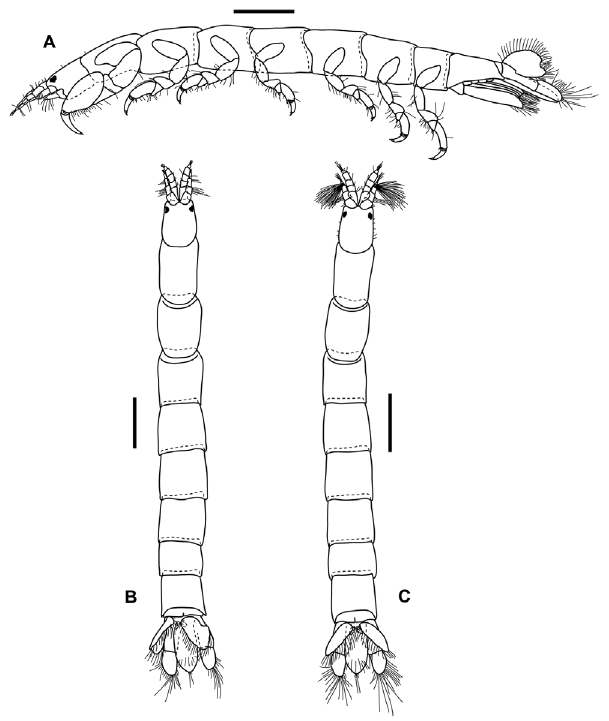
Figure 2. Tinggianthuraalba sp. n., holotype, female, (UKMMZ- 1479).